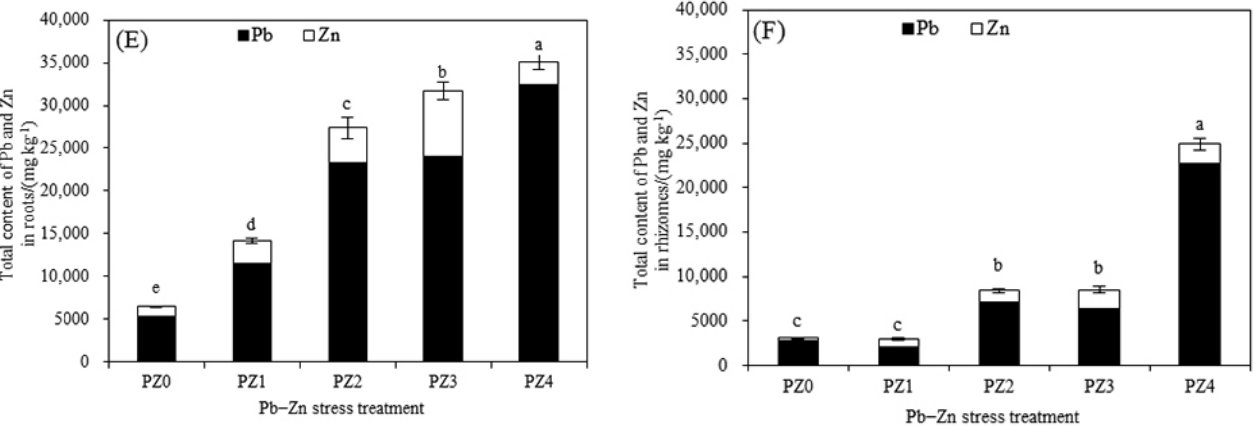
Figure 4. Impacts of different treatment durations and Pb–Zn treatments on Pb content in roots ( A ), Pb content in rhizomes ( B ), Zn content in roots ( C ), Zn content in rhizomes ( D ), the total content of Pb and Zn in roots after 20 days of treatment ( E ) and total content of Pb and Zn in rhizomes after 20 days of treatment ( F ). Along the x -axis of each graph, PZ0, PZ1, PZ2, PZ3 and PZ4 indicate that the Pb concentration is 300 mg/L and that the Zn concentrations are 0, 75, 150, 300, and 600 mg/L, respectively. Vertical bars represent the standard errors of the mean ( n = 3). Different letters indicate significant differences among treatments with different Zn concentrations under the same treatment time ( p < 0.05). ** indicates an extremely significant difference at 0.01 under the same treatment and different time ( p < 0.01).